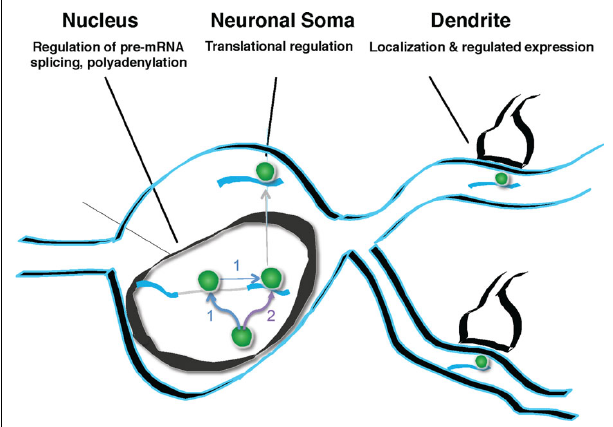
FIGURE 9 | Model of Nova action. Nova binds to pre-mRNA in the nucleus. This binding can, but need not be intronic (pathway labeled “1”). If binding sites are in the region of alternatively spliced exons, Nova can mediate alternative splicing, according to the rules of a functional binding map, such that the position of Nova binding determines the outcome of alternative exon inclusion. Subsequently, Nova may multimerize in cis upon the same transcript (pathway 1), or may be independently deposited upon additional mRNA binding sites, such as those in the 3 ′ UTR (pathway labeled “2”). 3 ′ UTR binding sites may determine additional processing steps (such as mediating alternative polyadenylation), and mediate soma and dendritic mRNA localization (as in the case of GIRK2-1 and perhaps GlyR α 2 mRNA). It is presumed, based for example on the studies of Singer and colleagues (Lawrence and Singer, 1986; Kislauskis et al., 1997; Rodriguez et al., 2008), that such RNA localization would be coupled to the regulation of translation. In neurons, coupling pre-mRNA binding to mRNA localization and translation offers the possibility of linking information content generated in the nucleus (alternative splicing or polyadenylation) with differential gene expression in